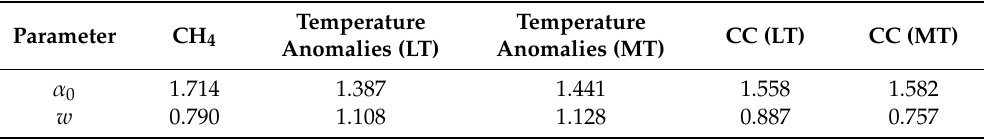
Table 1. Multifractal characteristics for CH 4 and temperature anomalies of the global LT and MT along with their cross-correlations